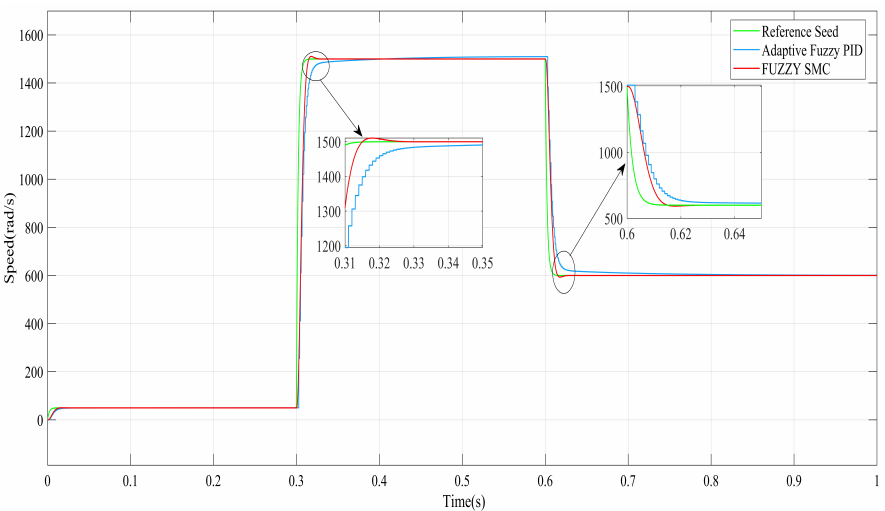
Figure 16. Measured speed to step change with